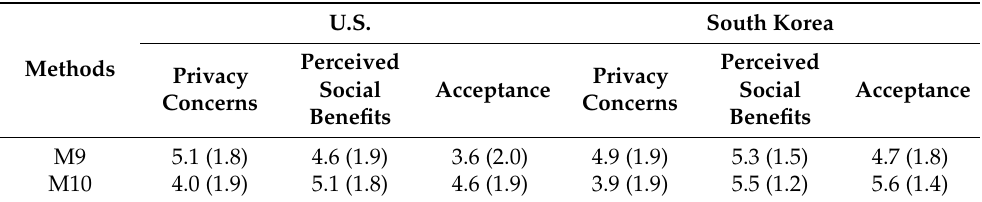
Table 9. Descriptive statistics of privacy concerns, perceptions of social benefits, and acceptance of the two location disclosure methods .